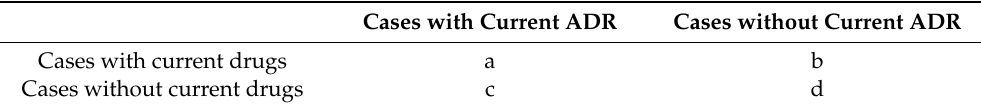
Table 5. Contingency table for calculating the ROR. Cases with Current ADR Cases without Current ADR Cases with current drugs a b Cases without current drugs c